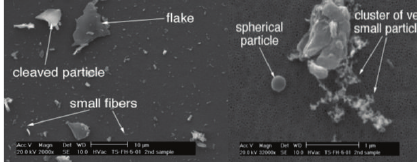
Figure 5: PMI undesired